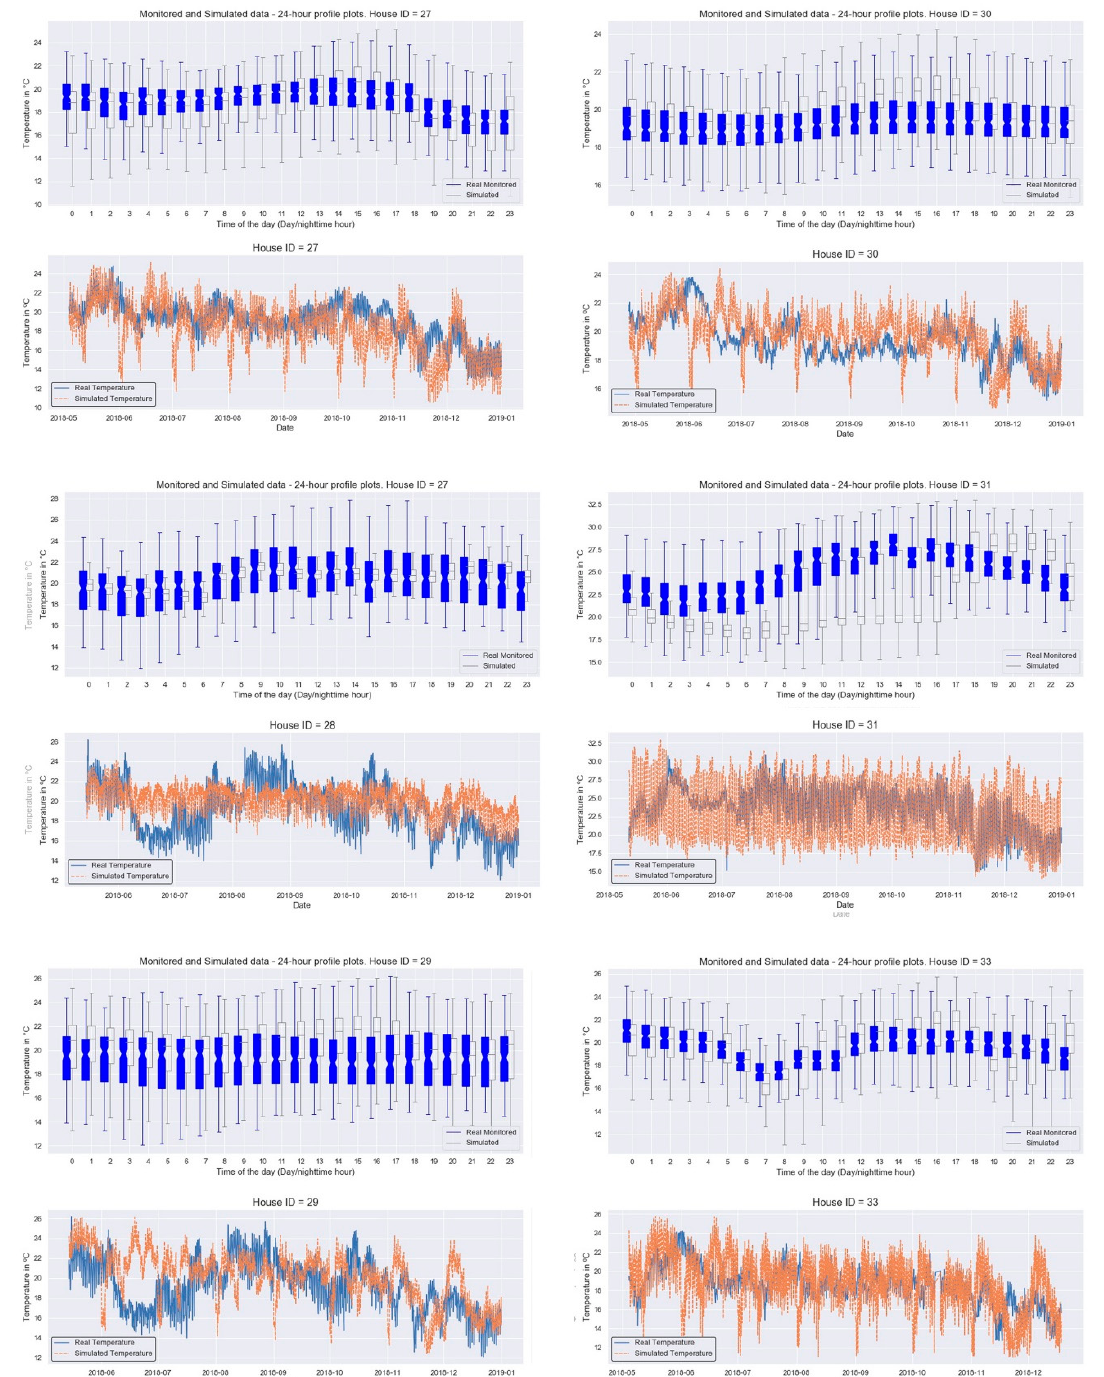
Figure A4. Results of the calibration of the models used for simulation—page 4.